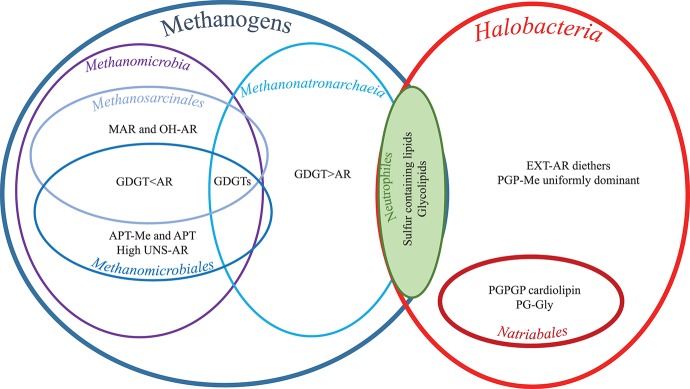
Characteristic lipids as grouped by physiology, phylogenetic orders and classes. For full species names and for groups, orders, and classes see Table 1. For lipid abbreviations see text.